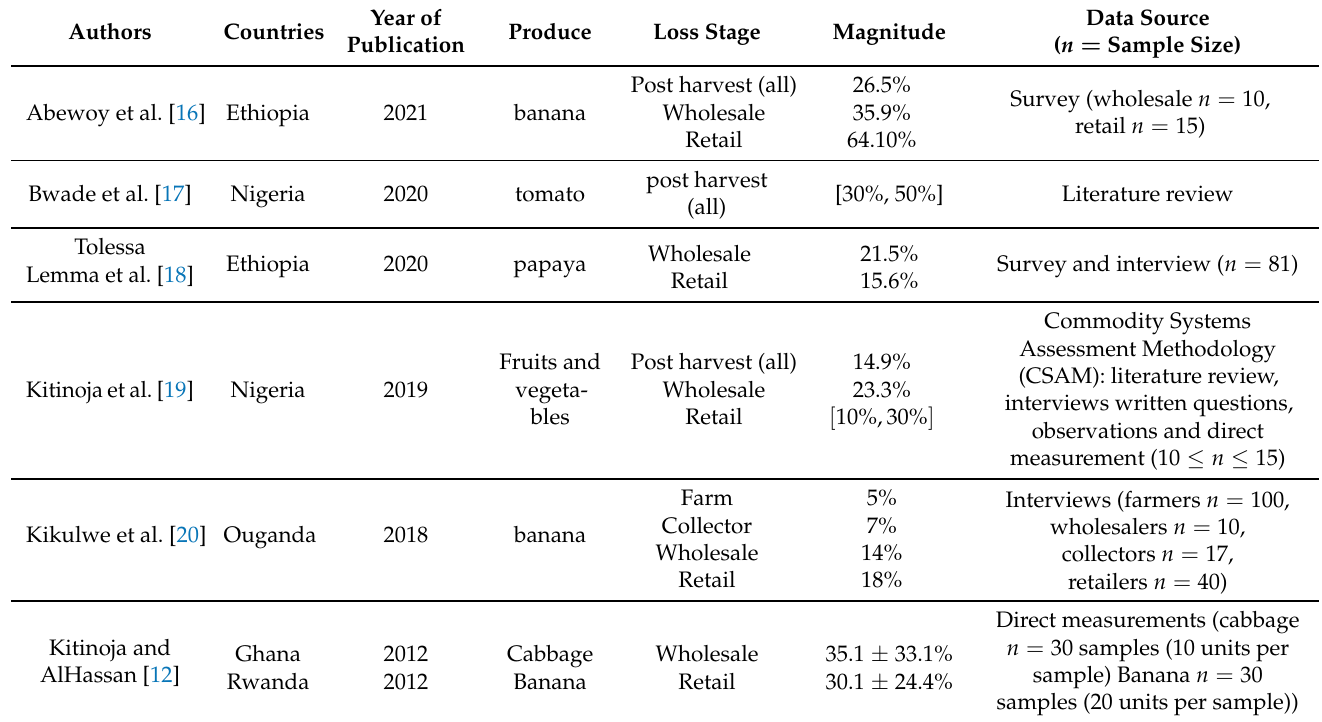
Table 1. Statistics about fruits and vegetables in SSA including magnitude and stages of fruit and vegetable losses present in the literature from 2012 to 2021. The table only presented statistics for papers showing results of food losses in a specific stage, specific fruits or vegetables and specific countries in